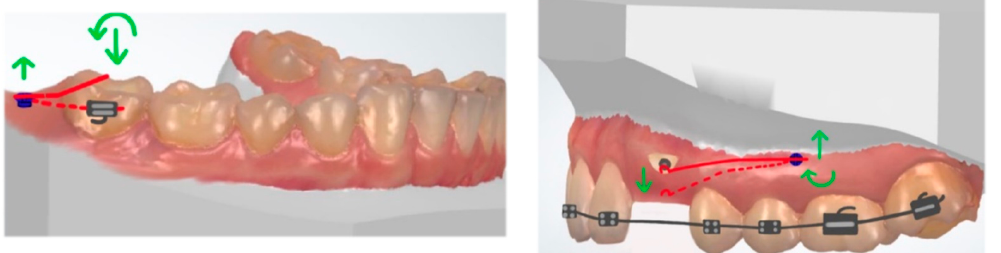
Figure 3. ( Left ): Placement of a TAD in line with or parallel to the dentition: no torquing moments on the TAD occurs. ( Right ) TAD is placed perpendicular to the long axis of the dentition; counterclockwise or clockwise torquing moments occurs (red: cantilever, green: force and moment).